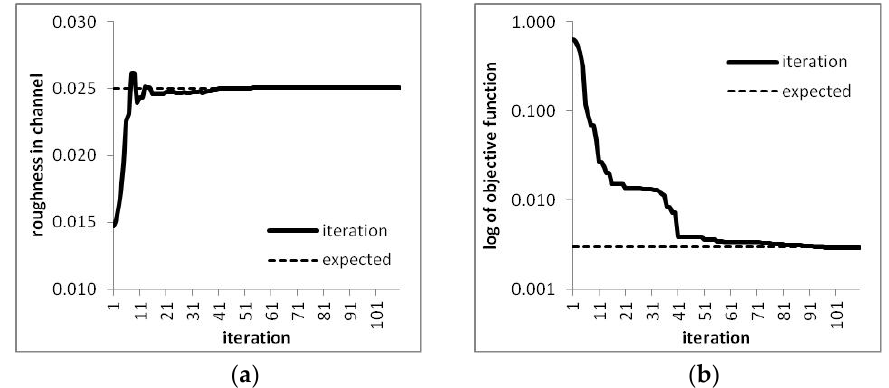
Figure 4. Results of Example 2: ( a ) convergence of channel roughness coefficient, ( b ) convergence of objective function.